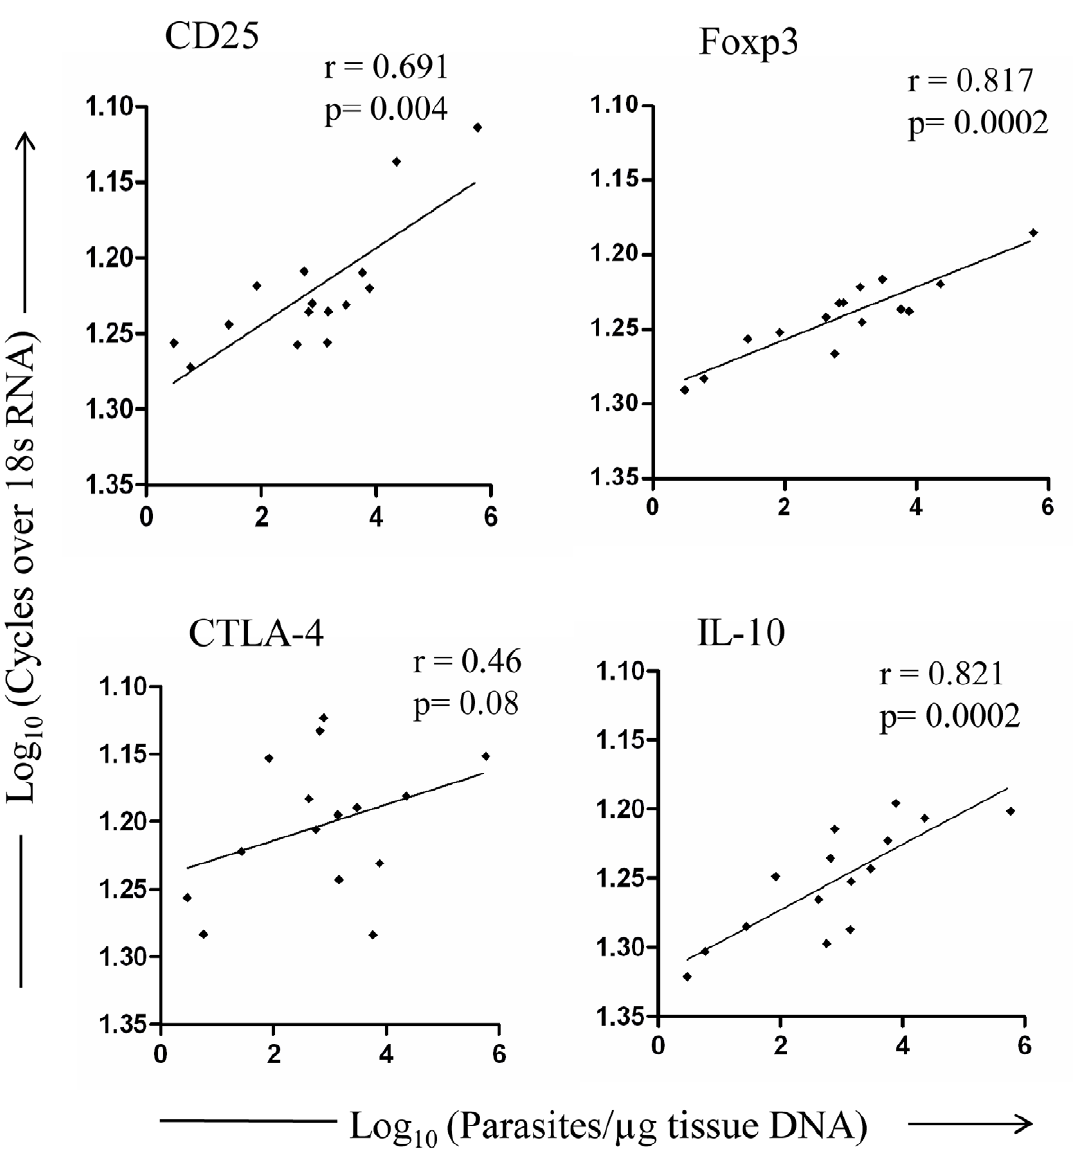
Figure 2. Correlation of mRNA expression of Treg markers and IL-10 with parasite load in PKDL. Relative mRNA levels of Treg markers and IL-10 with respect to parasite load within lesion tissues of PKDL patients (n=15). Plot was created using logarithmic values for cycles over 18sRNA and parasite load. Correlation was calculated using Spearman/Pearson correlation test. Diagonal line represents linear regression.